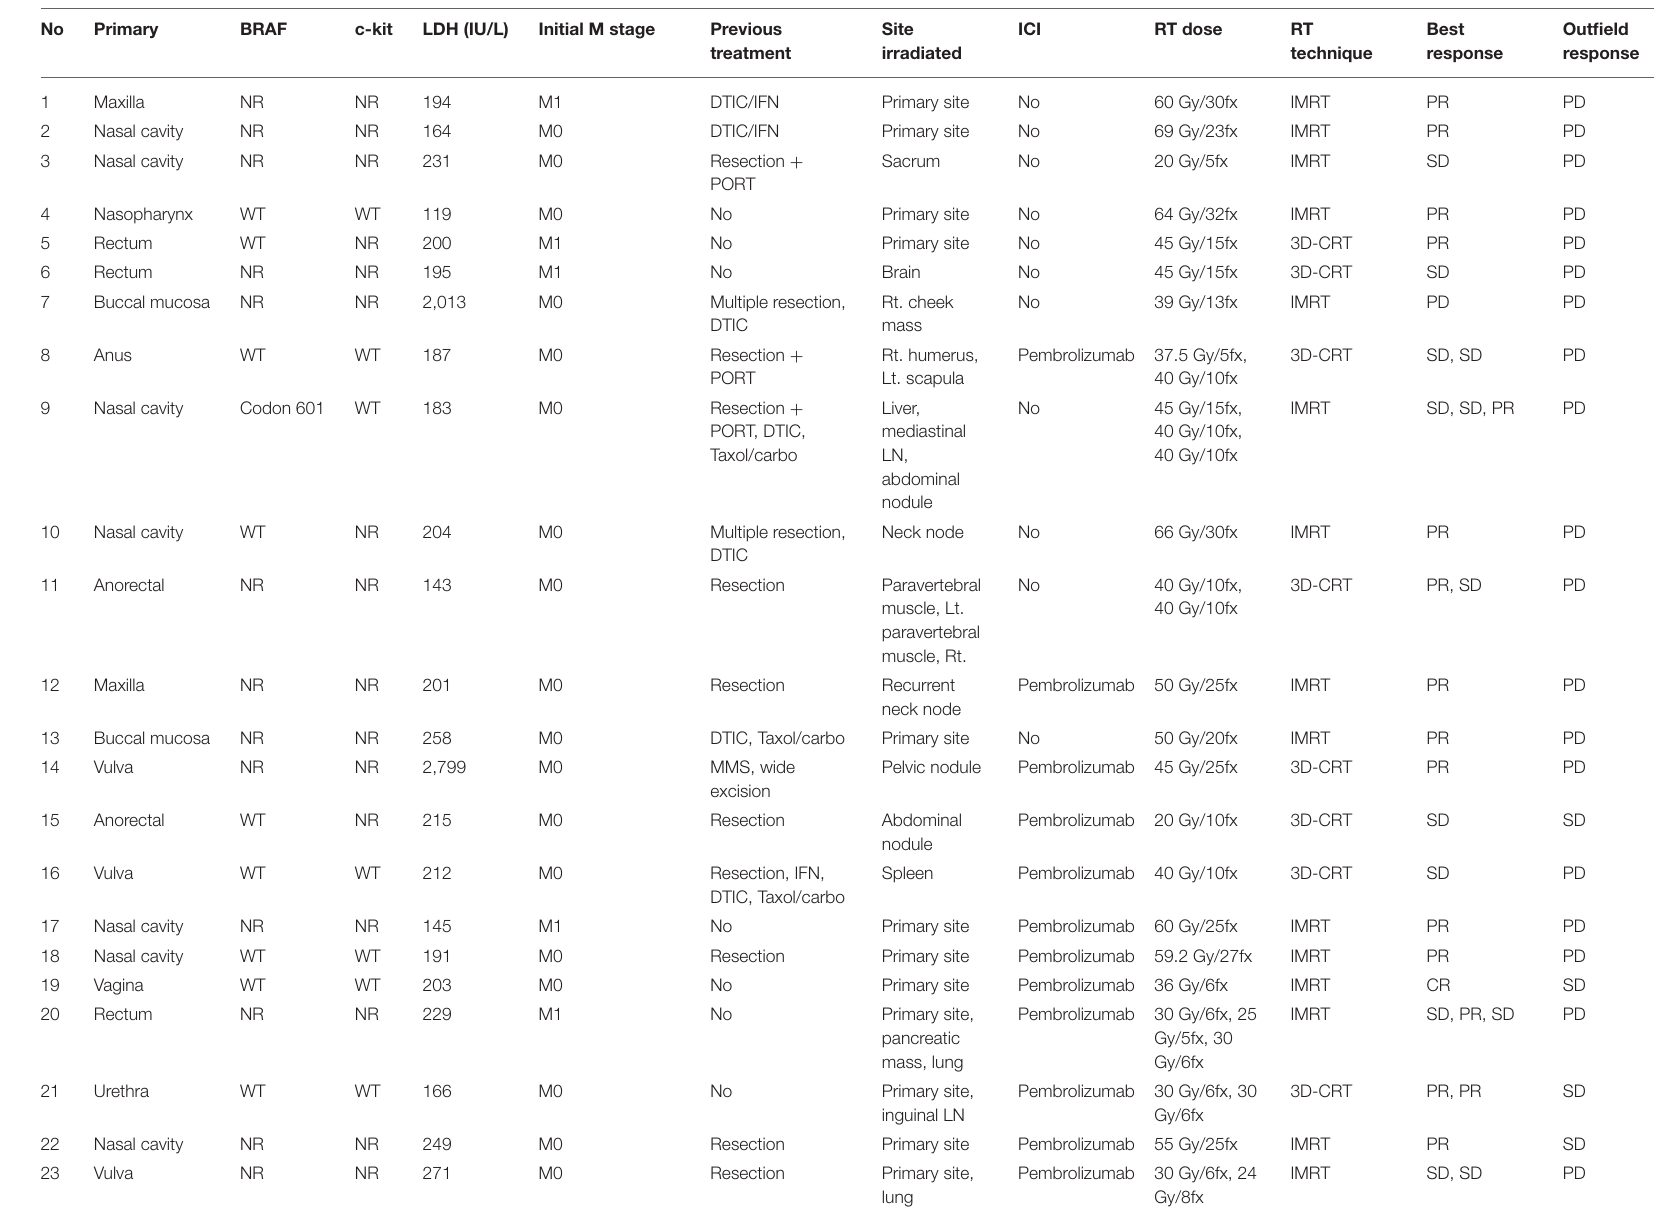
TABLE 2 | Detailed characteristics of patients treated with